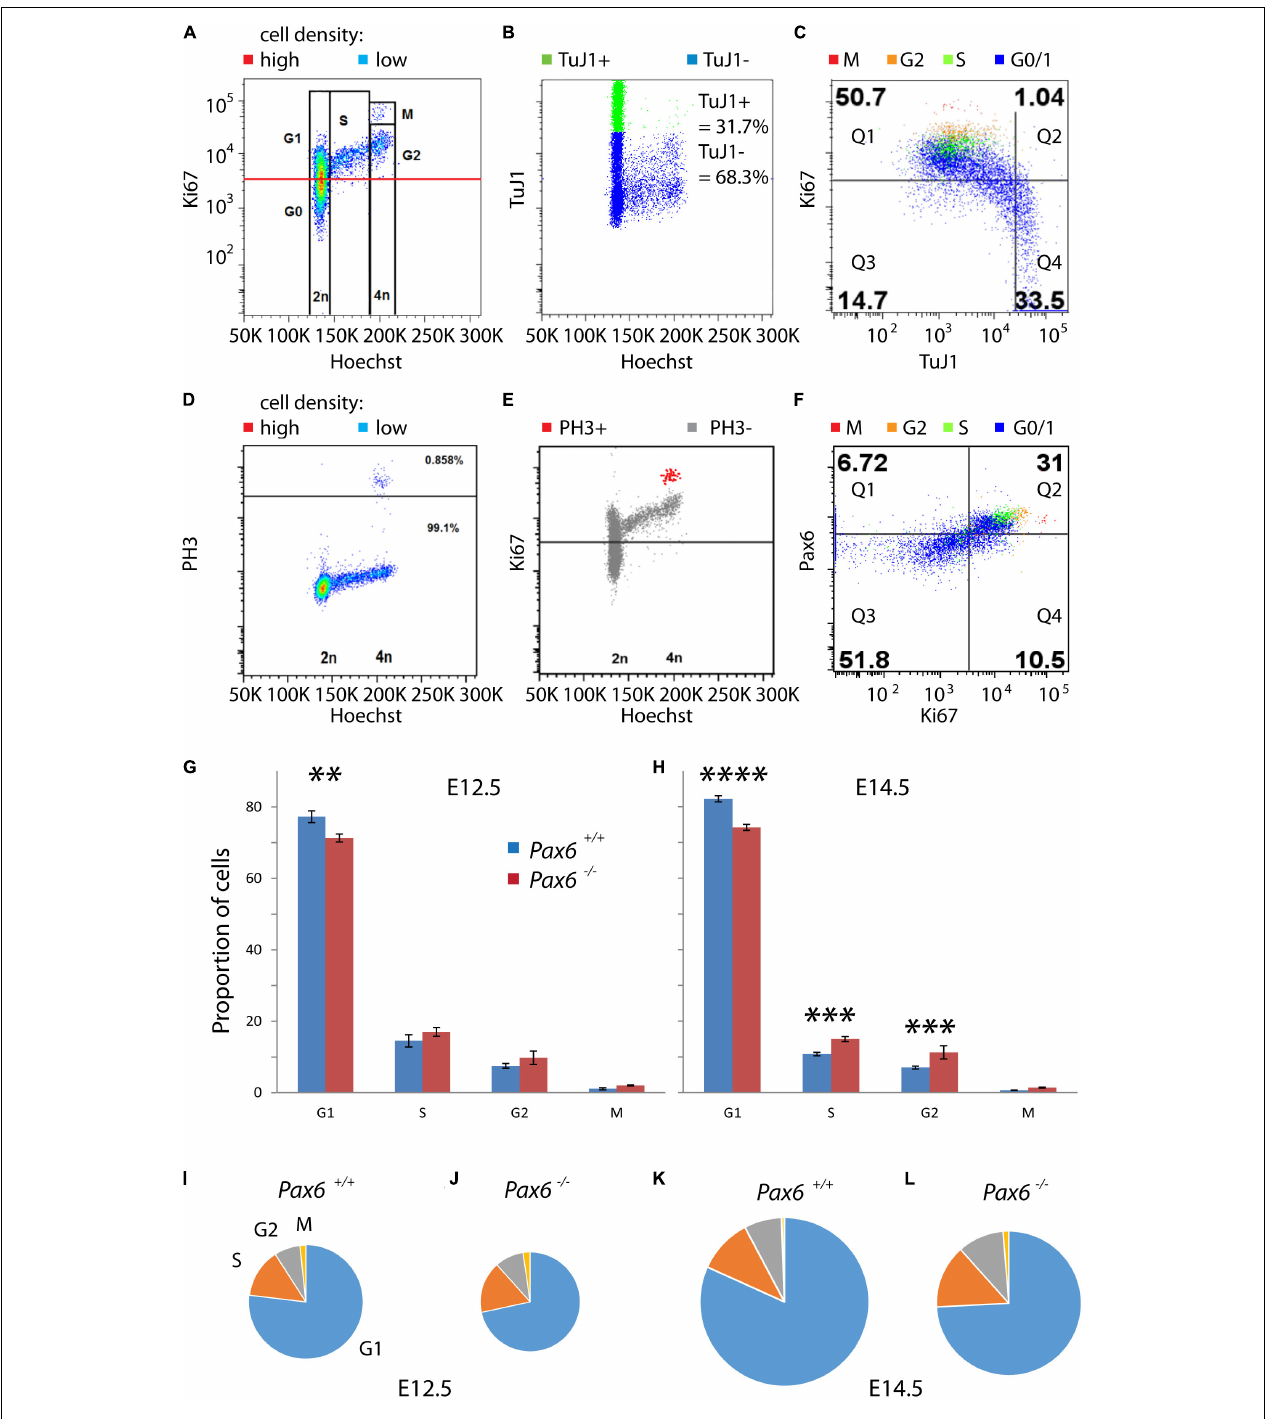
FIGURE 3 | Flow cytometric analysis of cell cycle phases of cortical progenitors in Pax6 + / + and Pax6 − / − embryos at E12.5 and E14.5. (A–F) Representative examples of flow cytometry showing how cells were assigned to specific stages of the cell cycle. Cells were labeled with Hoechst 33342 and antibodies for Ki67, class III beta-tubulin (TuJ1), phospho-Histone H3 (PH3) and Pax6. (A) Fluorescence intensity of Ki67 against Hoechst, shown as a heat-map with red areas containing most cells and blue areas fewest: Cells were classified as G1 if they had 2n DNA content and were positive for Ki67 (intensity values above the red line), which is a marker of proliferating cells. (B) Fluorescence intensity of TuJ1 against Hoechst: TuJ1 was used as a marker of differentiating neurons. (C) Fluorescence intensity of Ki67 against TuJ1, with different colors indicating cell cycle phase of each cell: In this sample, 98.0% (50.7/51.74) of Ki67+ cells were TuJ1– whereas 69.3% (33.5/48.3) of Ki67– cells were Tuj1+. (D) Fluorescence intensity of PH3 against Hoechst, plotted using the same method as in panel (A) : Cells in M